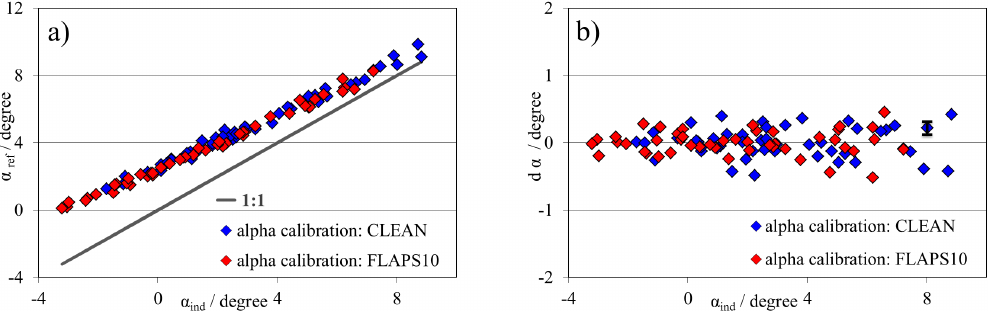
Figure 5. (a) Comparison of α ind with the measured reference values α ref = (cid:50) for 96 test points during six calibration flights. (b) Deviation of the corrected α values and the reference values ( (cid:50) ). A linear fit is performed with the results shown in (a) to correct the upwash effect for clean and flaps10